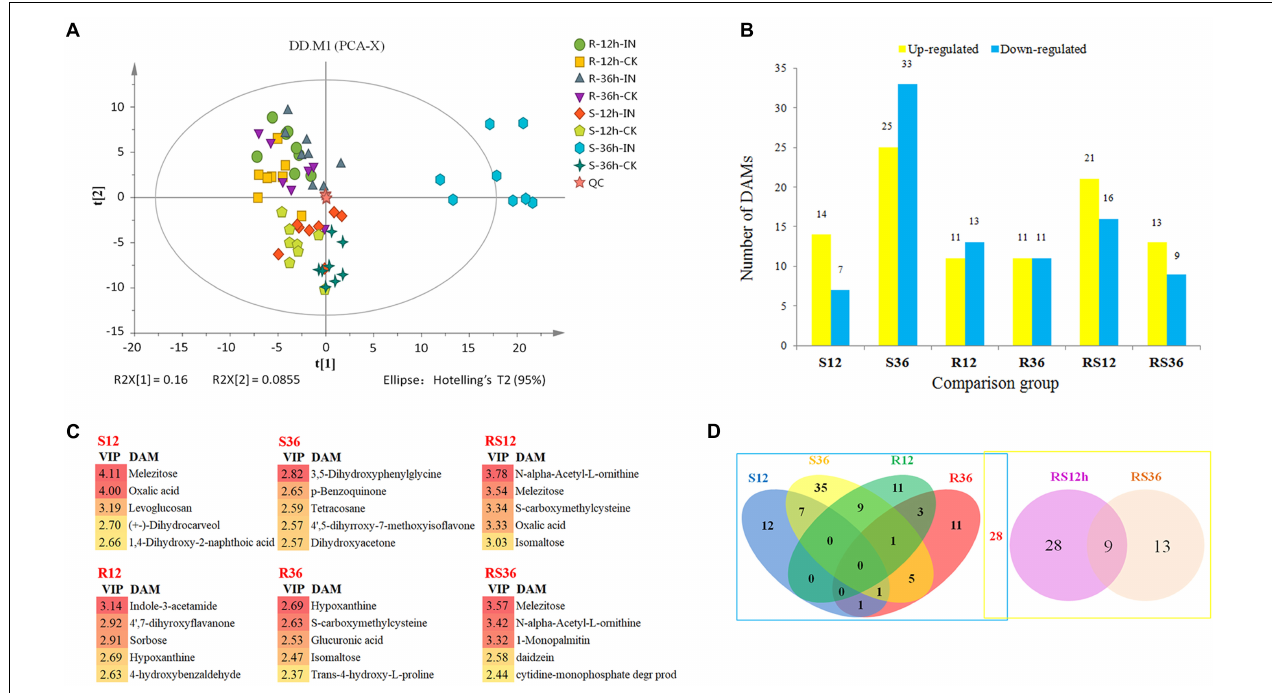
FIGURE 1 | (A) Principal component analysis (PCA) of metabolites from soybean hypocotyls infected with Phytophthora sojae and those under control conditions. Each sample included eight biological replicates. (B) Numbers of significantly differentially accumulated metabolites (DAMs). DAMs are shown in yellow (upregulated) and blue (downregulated). (C) List of the DAMs with top 5 VIP value of each comparison group. (D) Venn diagram analysis of the DAMs. The left rectangle contains DAMs whose levels differ between infected hypocotyls and the corresponding control, and the right rectangle contains DAMs whose levels differ between the R and S lines. R12: R-12h-IN vs. R-12h-CK; R36: R-36h-IN vs. R-36h-CK; S12: S-12h-IN vs. S-12h-CK; S36: S-36h-IN vs. S-36h-CK; RS12: R-12h-CK vs. S-12h-CK; and RS36: R-36h-CK vs. S-36h-CK. IN, inoculated; CK, control